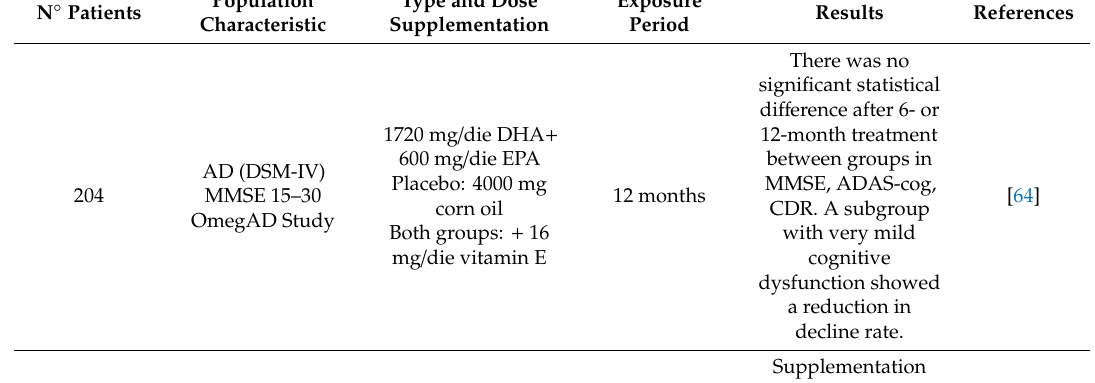
Table 7. Clinical trials assessing the impact of omega-3 fatty acids supplementation in AD patients. N ◦